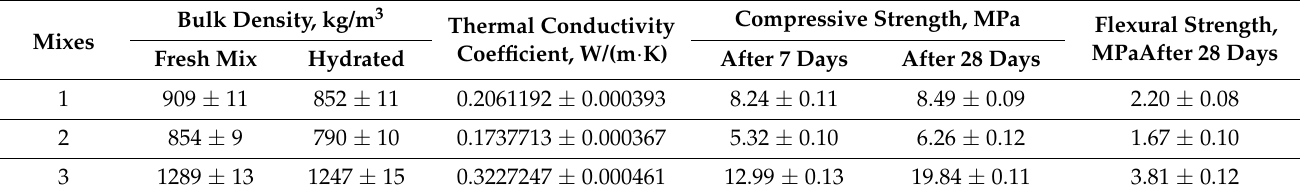
Table 5. Samples’ physical and mechanical